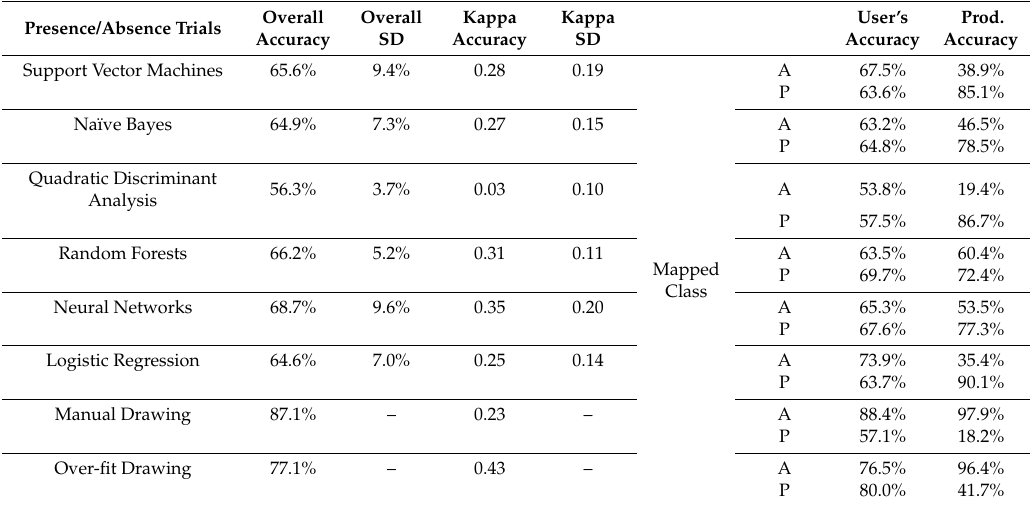
Table 1. Overall, kappa, user’s, and producer’s accuracies of MTMF-classified maps in which the presence/absence of leafy spurge was matched to field reference data using cross-validated supervised learning algorithms. SD = standard deviation of overall and kappa accuracies obtained through 10-fold holdout cross-validation. A = Absent, P =